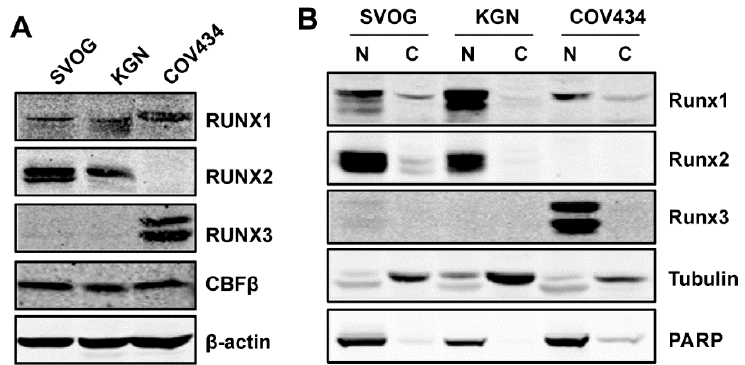
Figure 1. Expression of runt-related transcription factor (RUNX) proteins in immortalized granulosa and granulosa cell tumors of the ovary (GCT) cell line. ( A ) The expression of RUNX proteins and core-binding factor- β subunit (CBF β ) in SVOG (immortalized human granulosa), KGN (adult GCT), and COV434 (juvenile GCT) cells was examined by immunoblotting. β -actin was used as the loading control. ( B ) Nuclear localization of RUNX proteins was confirmed using subcellular fractionation and immunoblotting. Tubulin and PARP were used as loading and fractionation controls for the cytosolic and nuclear fractions, respectively. N: Nuclear fraction; C: Cytosolic fraction.